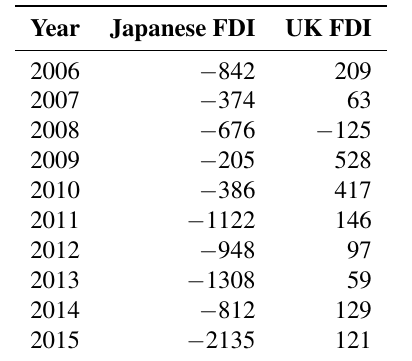
Foreign direct investment (FDI) between Britain and Japan (bil. yen).